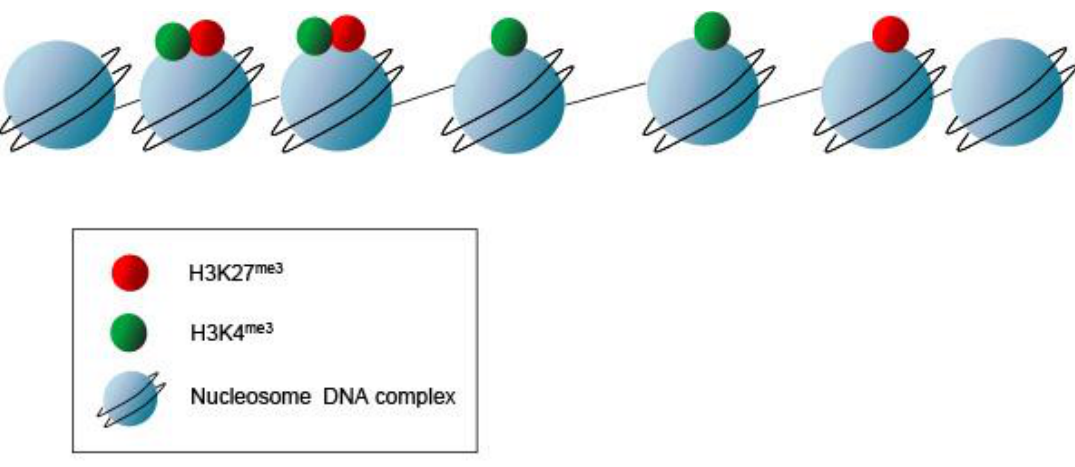
Figure 6 . Post translation modifications (PTMs) occur on the histone tails and a PTM code designates genes “on” or “off”. In early embryos and ES cells, modifications can dictate gene activation or repression. One example is the bivalent marks found in undifferentiated ES cells in which histone H3 lysine 27 is trimethylated (H3K27me3) and histone H3 lysine 4 is trimethylated (H3K4me3). H3K27me3 is typically a repressive mark whereas H3K4me3 denotes an active